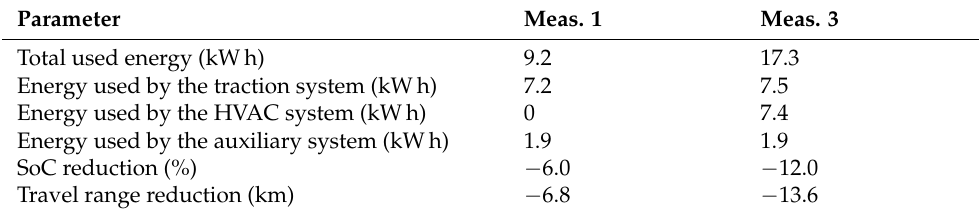
Table 7. Comparison of the maximum energy consumption, SoC and travel range reduction at the end of the Meas. 1 and Meas. 3.